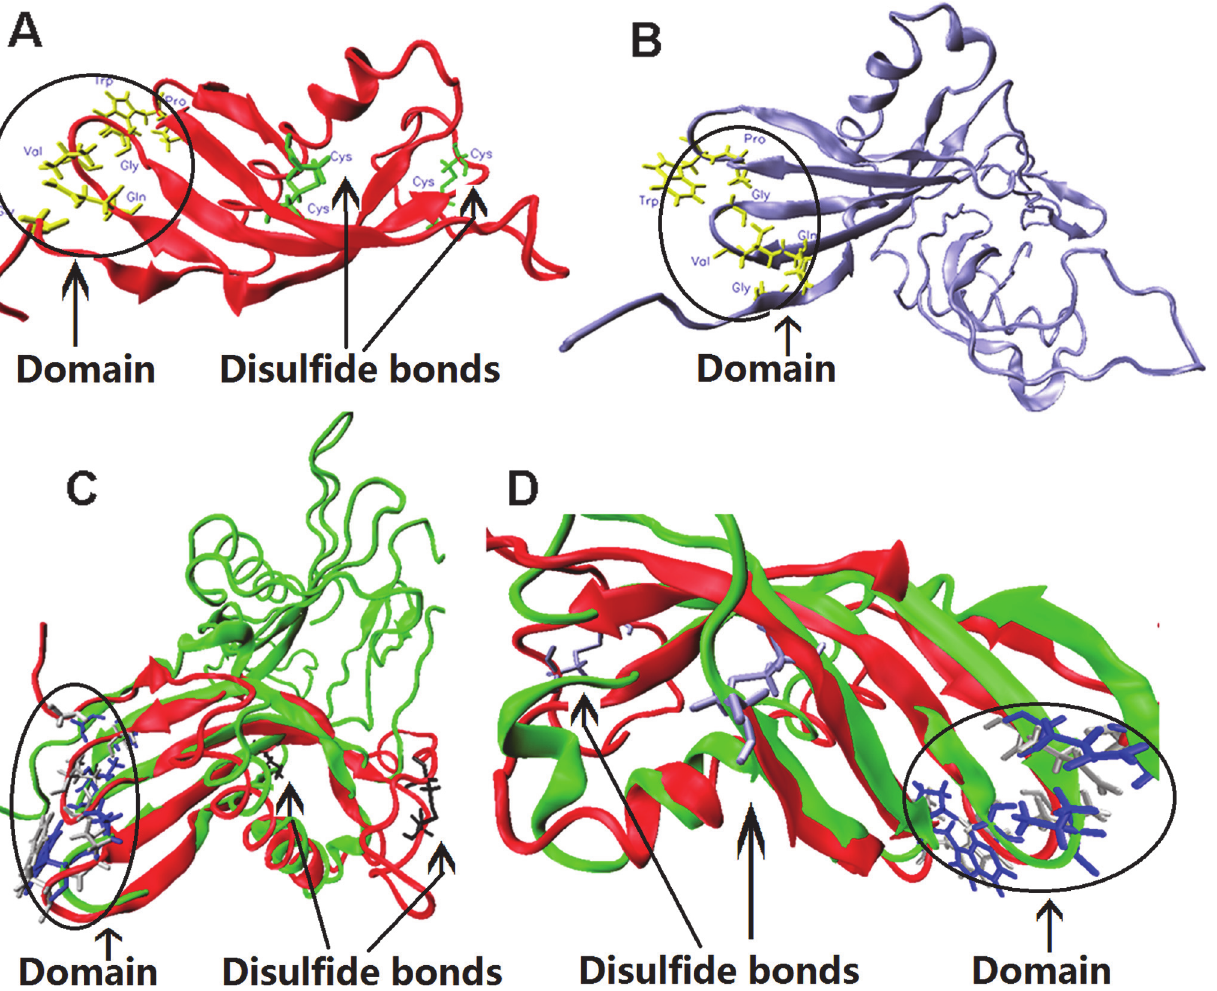
Fig 4. Comparison of tertiary structures for chicken and T . solium cystatins. The 3D structures for chicken cystain (A) and T . solium cystatin (B) are shown. The cystatin models of chicken and T . solium are superimposed in (C). The opposite side of the (C) map are enlarged and shown in (D).